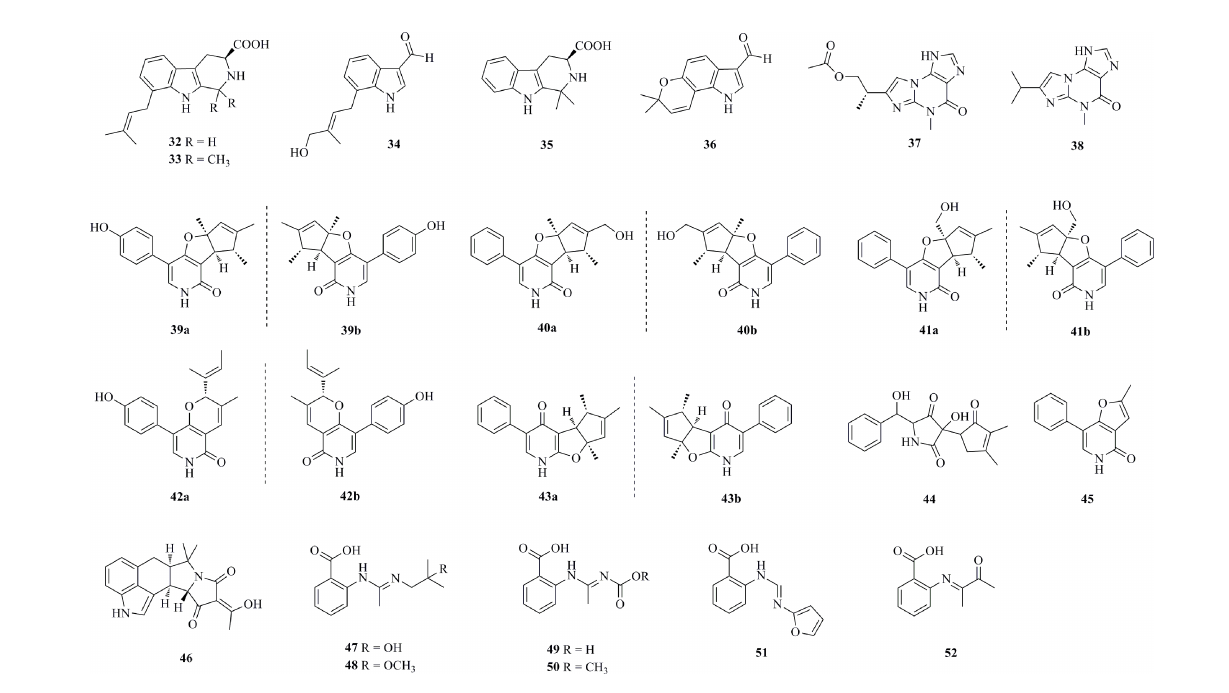
FIGURE 3 | N-containing compounds isolated from deep-sea fungi ( 32 − 52